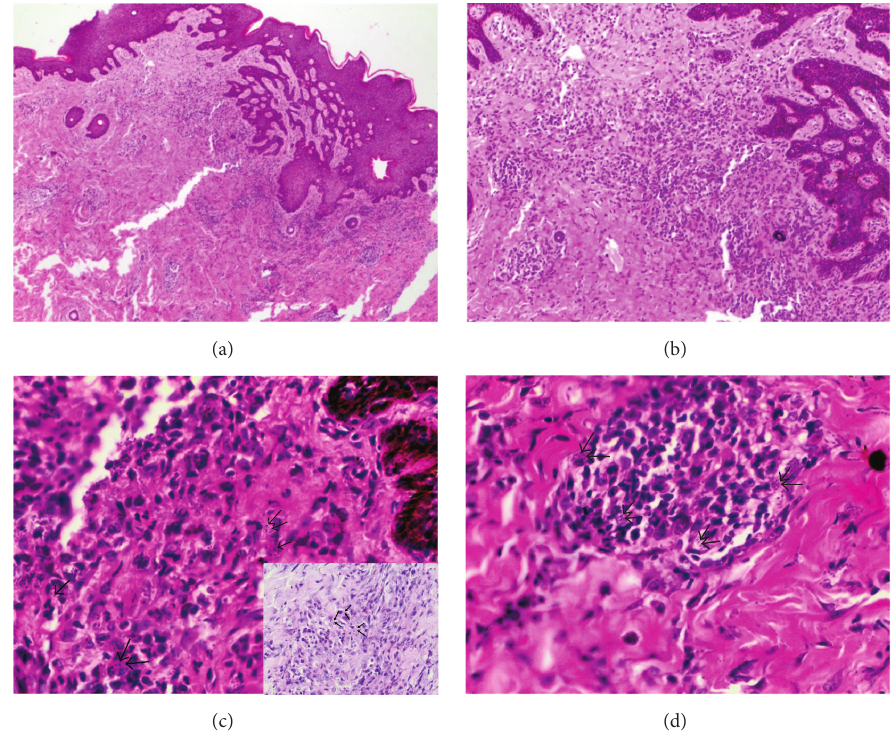
Figure 2: (a) Diffuse inflammatory infiltrate composed of chronic inflammatory cells and macrophages (H&E, × 40); (b) yeast-like forms widely dispersed in the dermis (H&E, × 100); (c) yeast-like forms widely dispersed in the dermis, black arrows pointing out the spores (H&E, × 400). Insert shows a period acid-Schiff stain with arrows pointing out the fungal spores; (d) a granuloma composed of macrophages containing S. schenckii organisms (H&E, ×